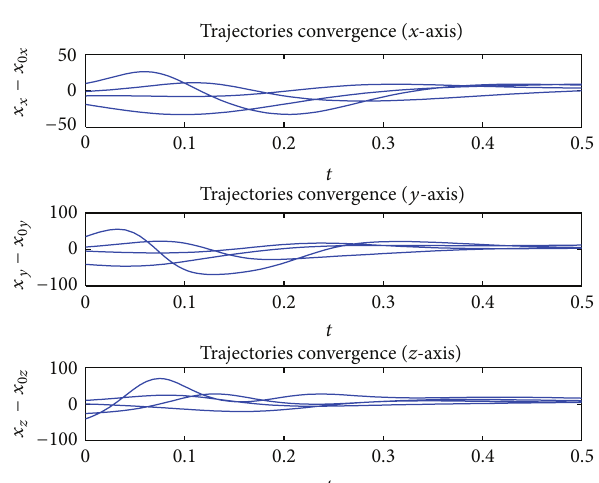
Figure 2: The trajectories of four agents in the dynamical network without a state predictor.